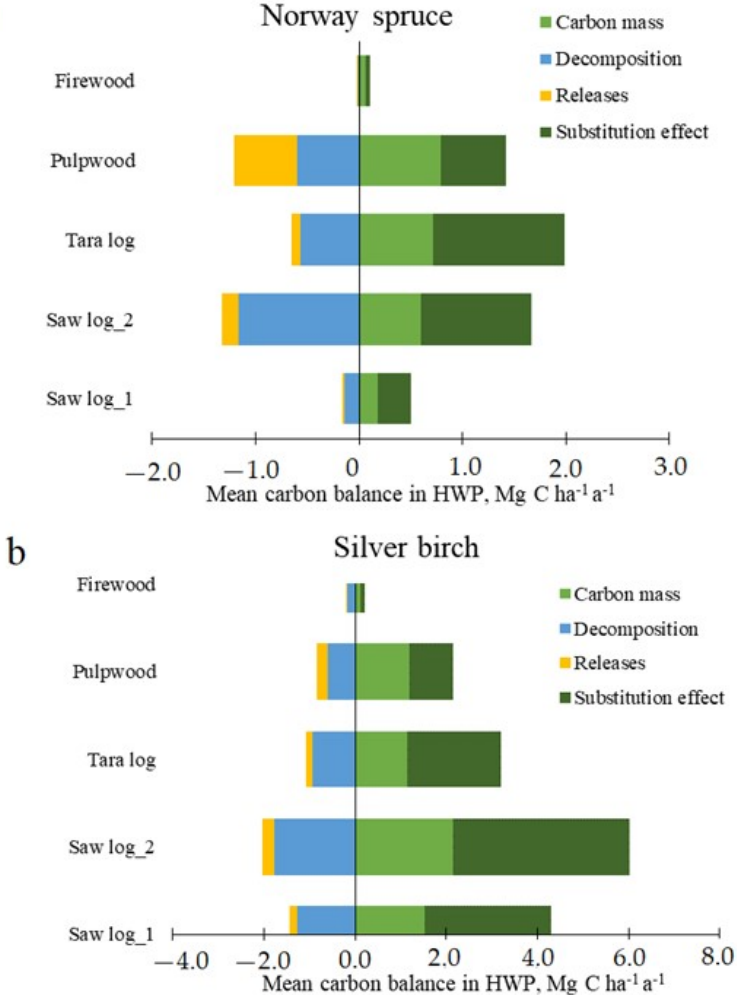
Figure 2. Carbon balance of harvested wood products. ( a )—Carbon balance of harvested wood products of Norway spruce, ( b )—Carbon balance of harvested wood products of silver birch. HWP—harvested wood products, HQ—high quality saw logs.